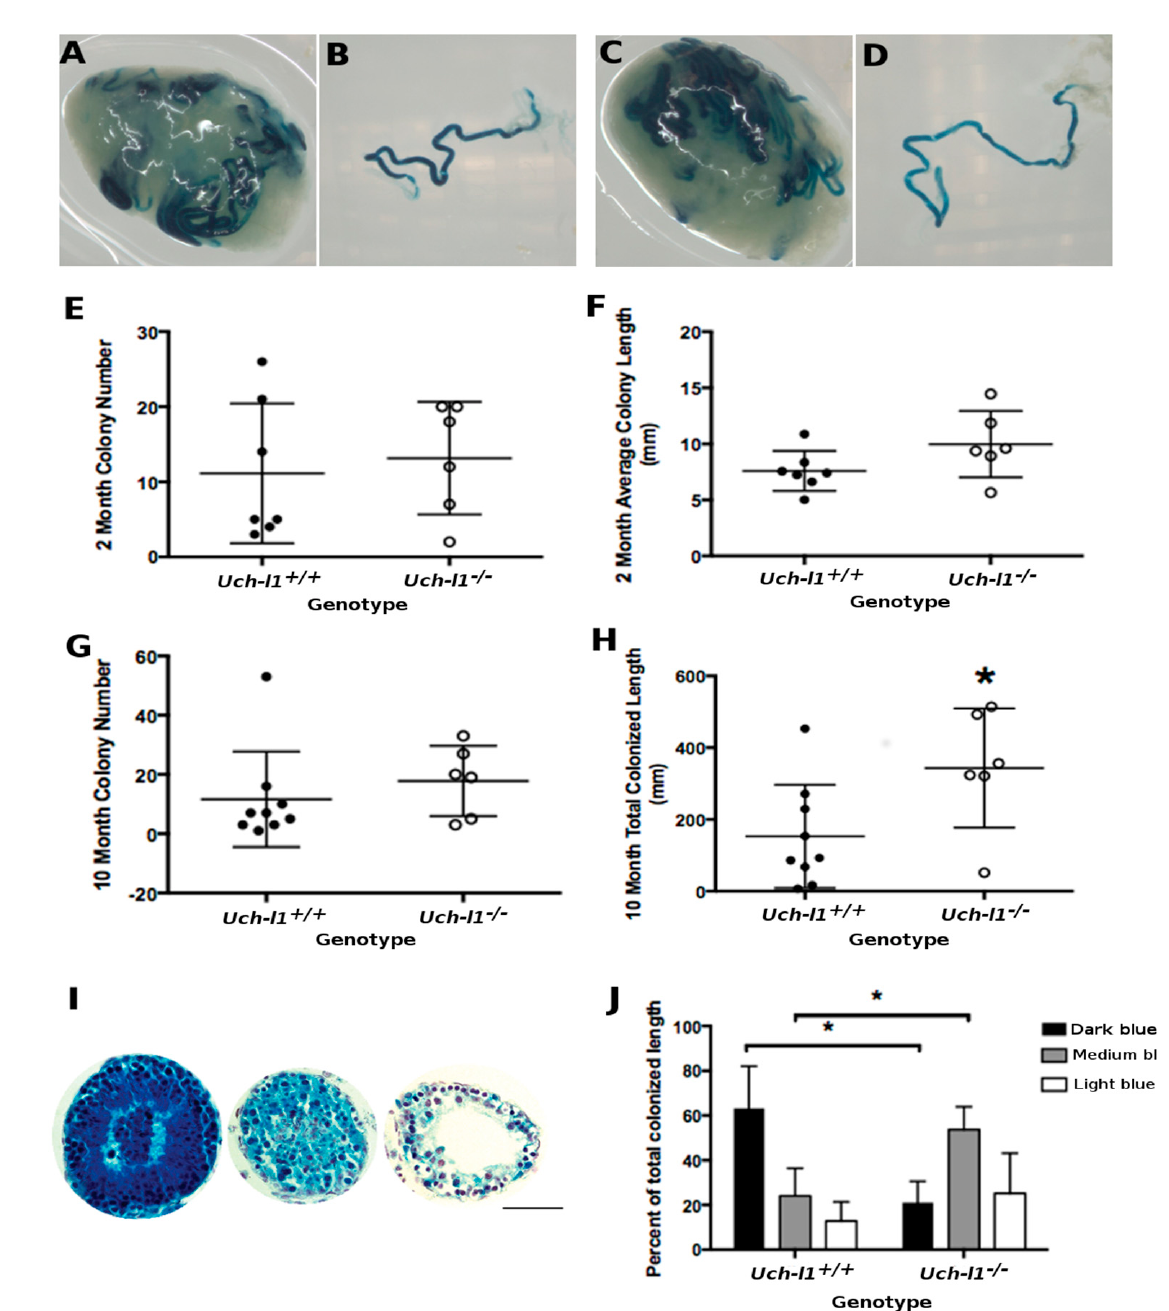
Figure 6. Transplantation of Uch-l1 +/+ and Uch-l1 − / − SSCs. ( A ) Recipient testis transplanted with Uch-l1 +/+ SSCs collected